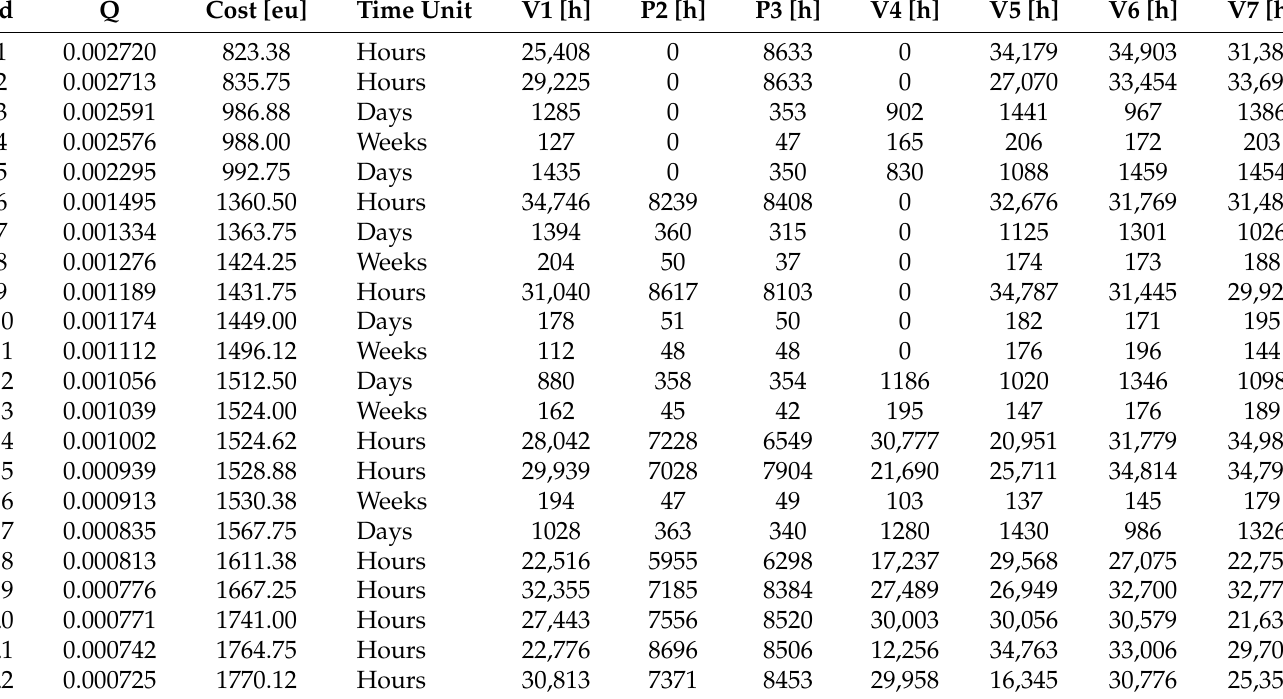
Table 15. Optimum solutions (encoding